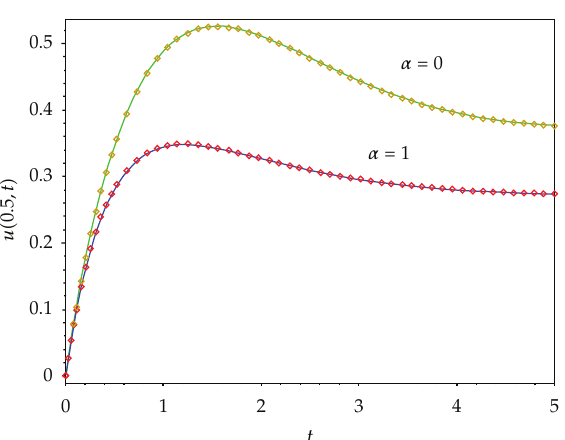
Figure 1: Comparison of exact analytical and numerical solutions of centerline velocity field for μ 1 (cid:8) 0, S 1 (cid:8) 2, S 2 (cid:8) 1, and h (cid:8) 1 for both permeable wall (cid:6) α (cid:8) 1 (cid:7) and impermeable wall.